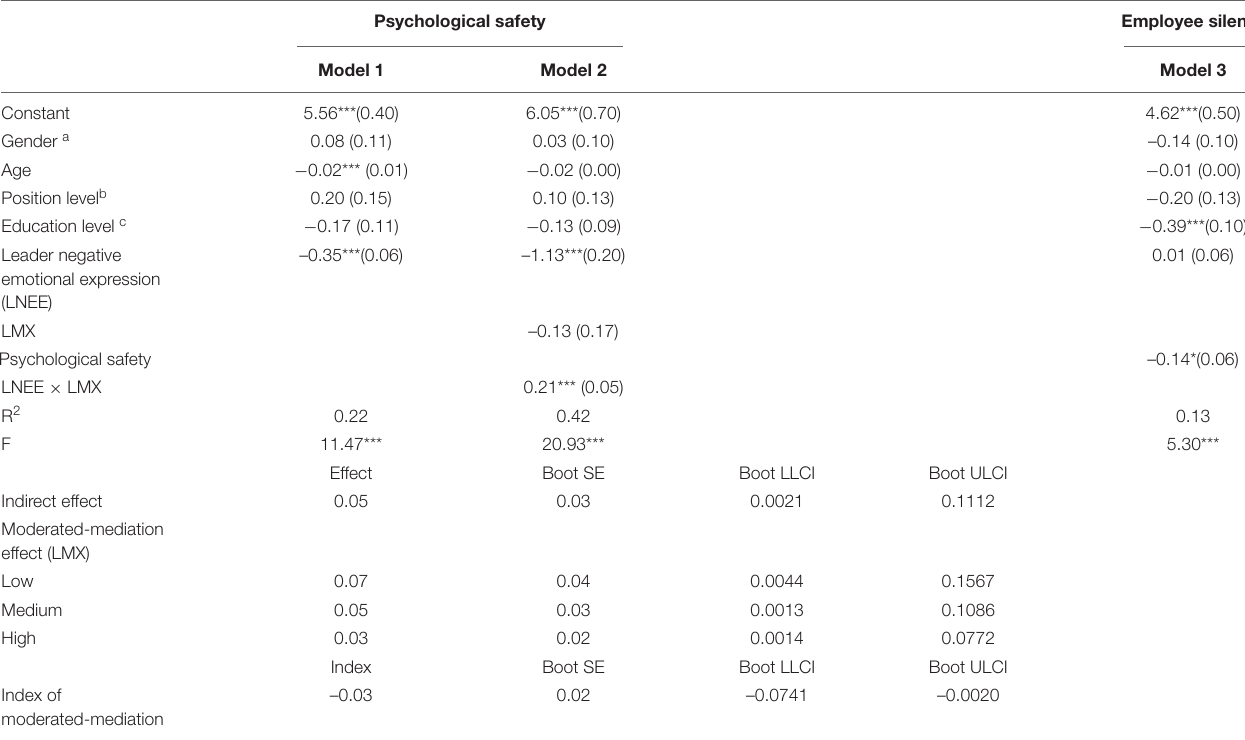
TABLE 2 | Results of regression analysis and moderated-mediation